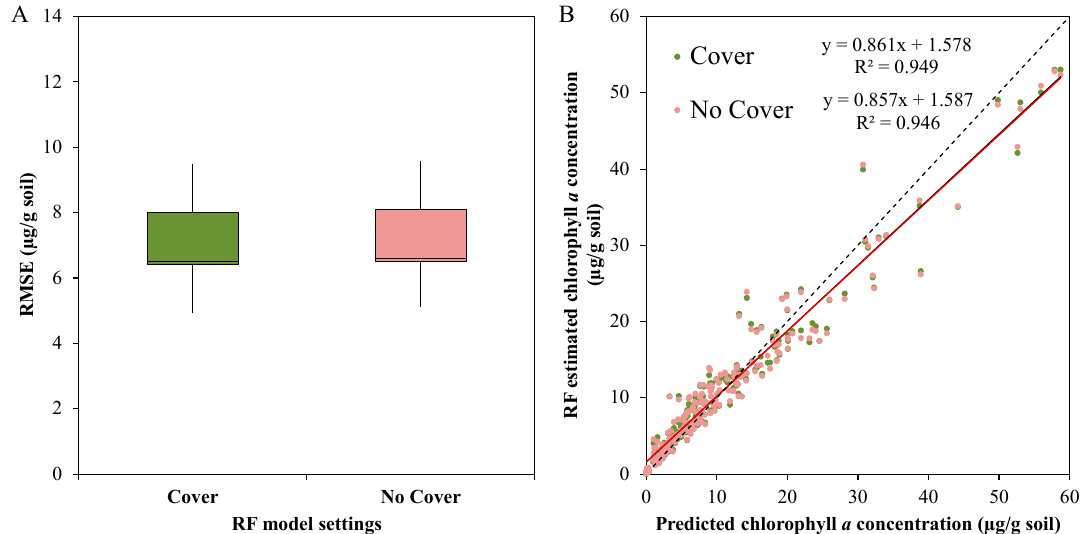
Figure 9. Random forest models (RF) fit: ( A ) Box plots showing mean (line), the lower and upper quartile (box), and the minimum and maximum values (whiskers) of the mean root-mean-square error (RMSE; µ g / g soil) obtained by the 20-fold cross-validations of the model that exclusively considered spectral properties derived from the two main absorption peaks (red) and the RF model also including biocrust coverage (green). ( B ) Linear regression between measured the chlorophyll a concentration ( µ g / g soil) and estimations obtained when the RF model that exclusively considered spectral properties derived from the two main absorption peaks (red) and the RF model also including biocrust coverage (green) were applied to the complete dataset.